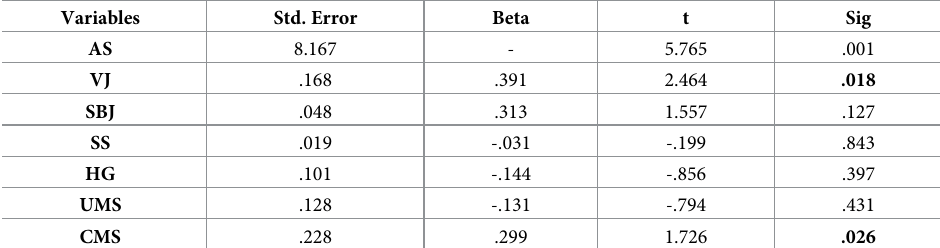
Table 1. Multiple linear regression analysis for feature extraction.